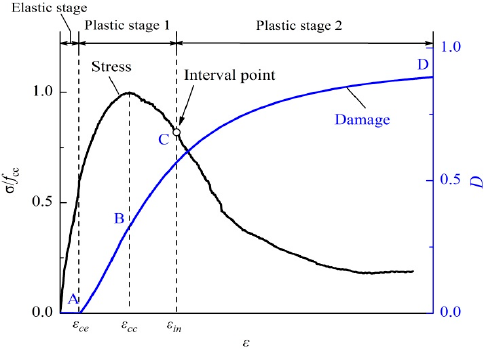
Figure 8. Characteristics of the damage evolution curve showing the different stages (Elastic, Plastic 1, and Plastic 2) related to the stress ( left axis) and damage ( right axis).